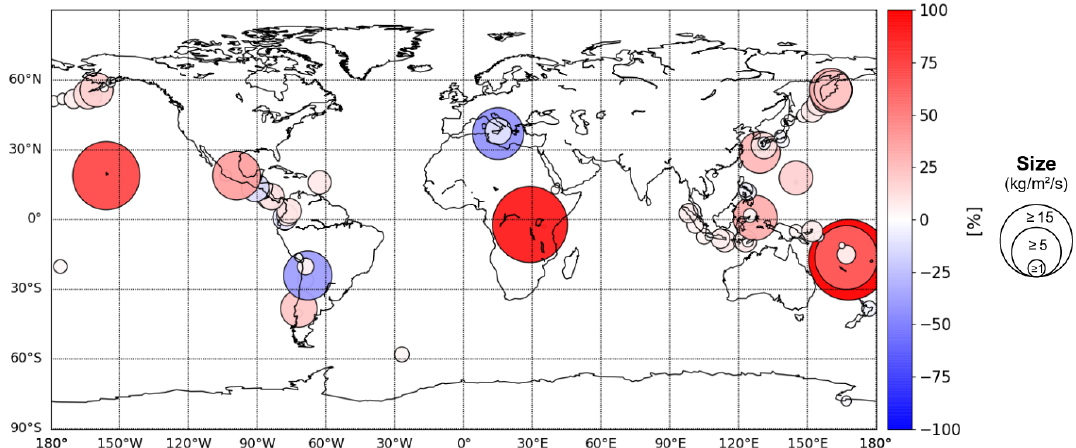
Figure 2. The 2013 annual average ratio between volcanic SO 2 emissions in the Carn et al. (2016, 2017) and Andres and Kasgnoc (1998) inventories. The size of the circles represents the absolute difference in kilograms per meter per second (kgm − 2 s − 1 ), while the color represents the relative difference in